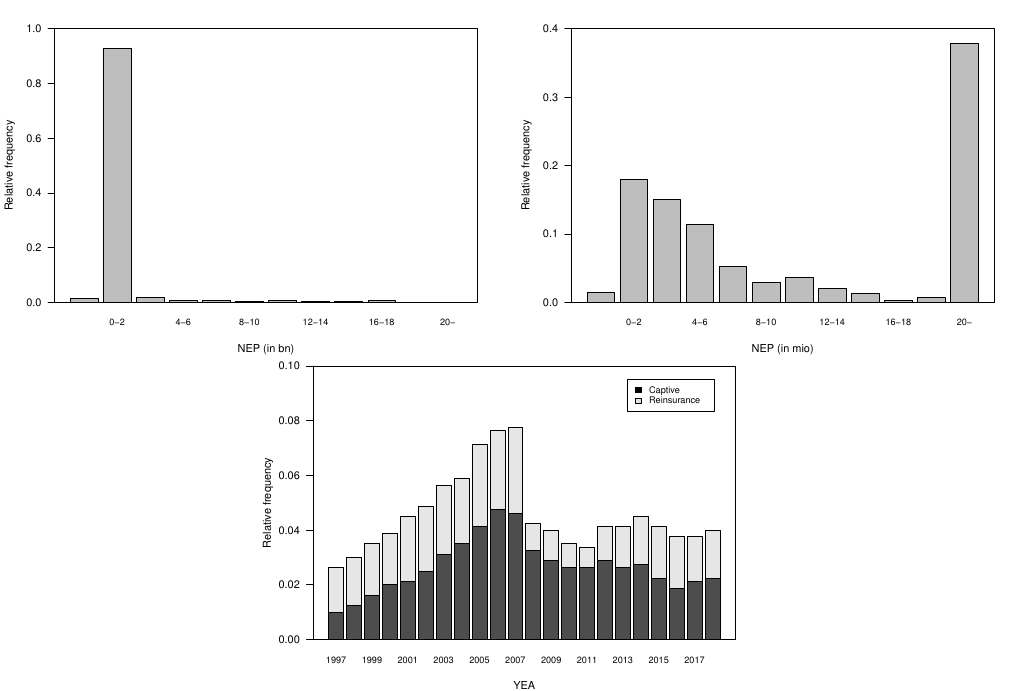
Figure A2. Relative frequency of the net earned premium ( NEP ) and of the calendar year ( YEA ) of reinsurance undertakings. The figure presents twice the relative frequency of the NEP : once sliced by billion and once sliced by million, whereby the last band includes all remaining higher